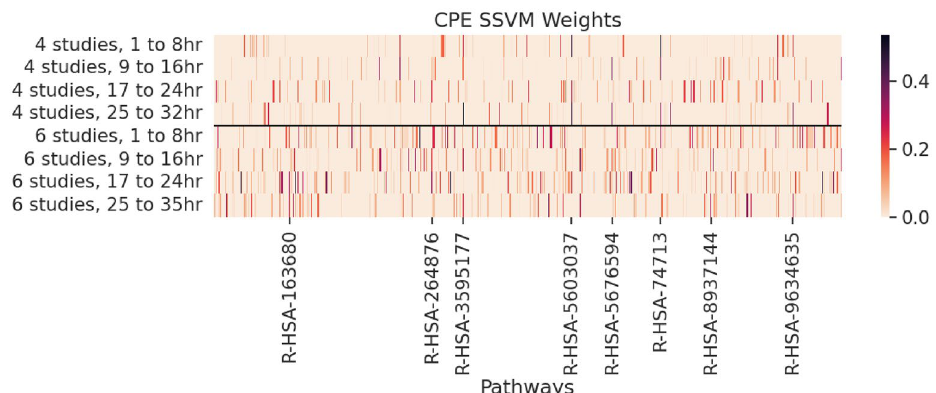
Figure 3. SSVM weights for the 4 and 6 study training datasets by pathway. The CPE configuration with pre- computed, directed edges/ PageRank centrality.